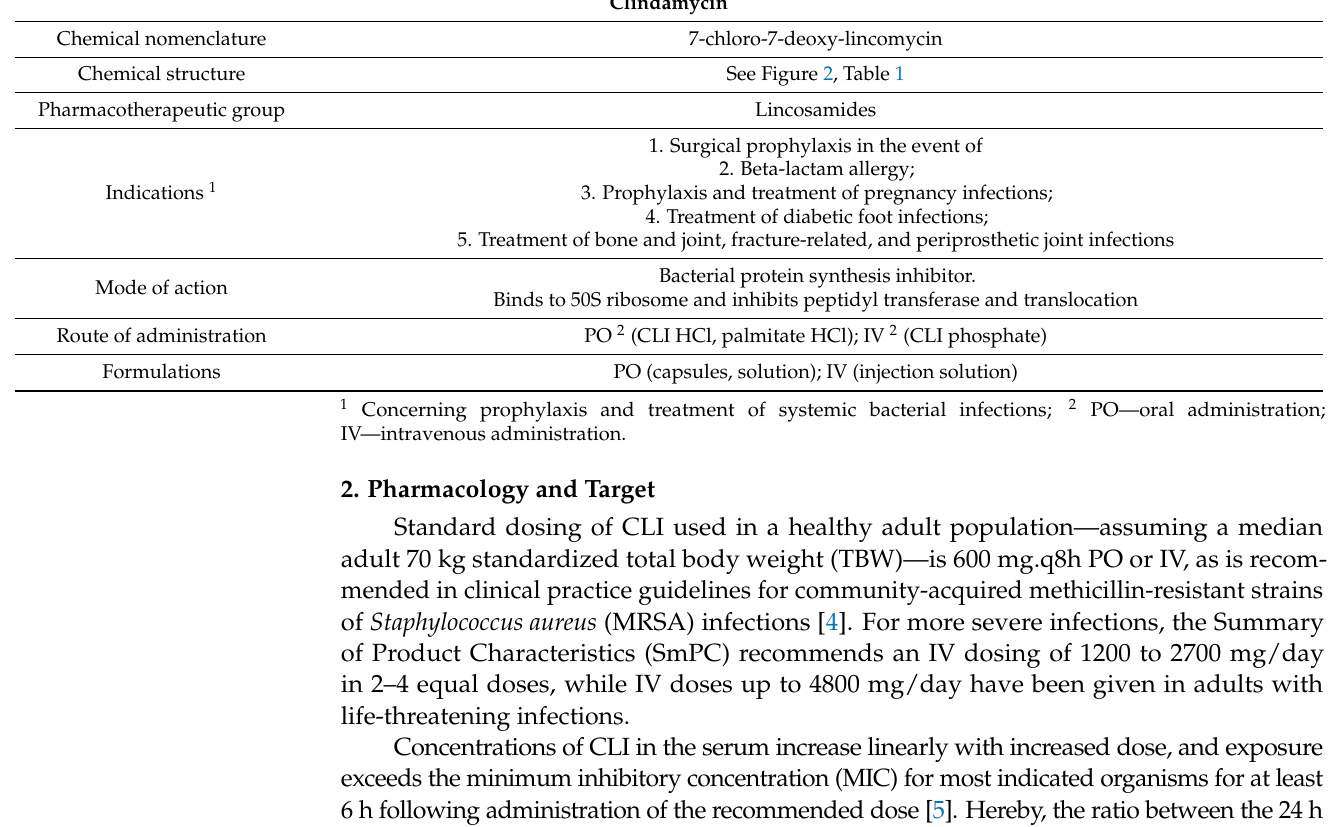
(Table 2): capsules (75 mg, 150 mg, 300 mg) and a solution (75 mg/5 mL) for PO administra- tion, and a 150 mg/mL IV solution for injection or infusion. IV formulations are available as CLI phosphate (300 mg/2 mL, 600 mg/4 mL, 900 mg/6 mL), and CLI phosphate in D5W